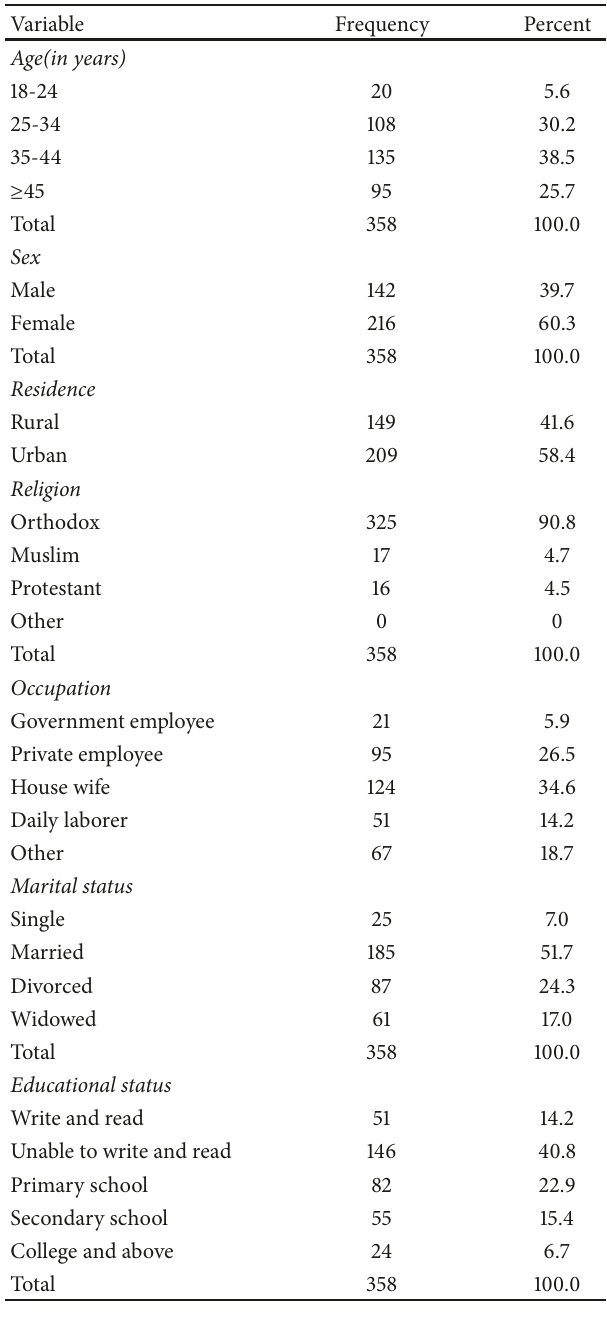
Table 1: Demographic characteristics of HIV infected persons